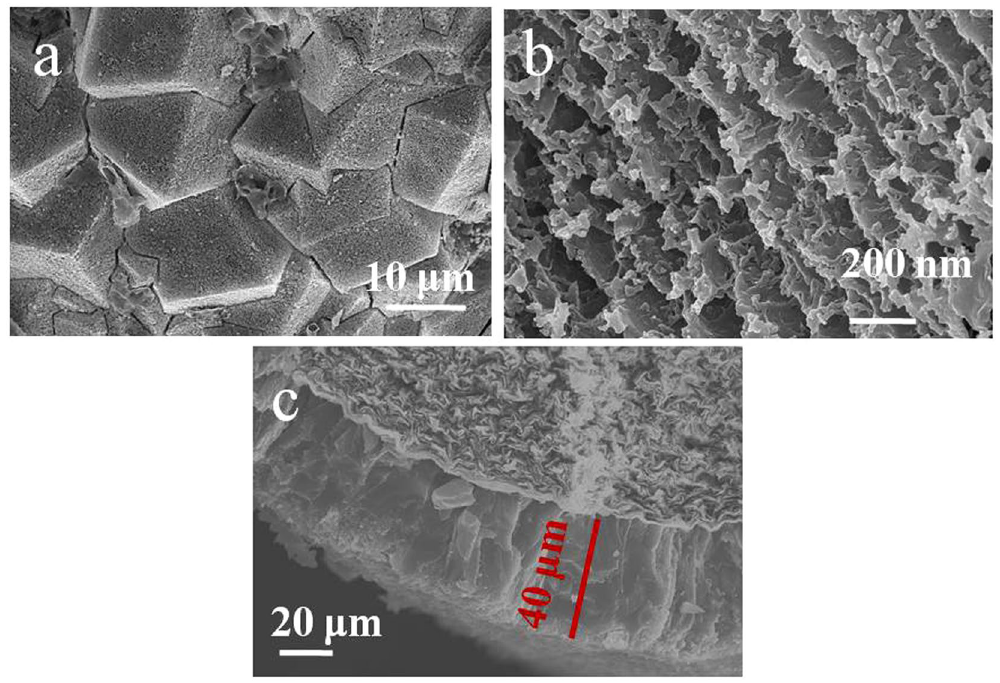
Figure 3. SEM images of ZIF-8/PEG-NH 2 membrane. ( a ) low magnification, ( b ) high magnification, ( c ) cross